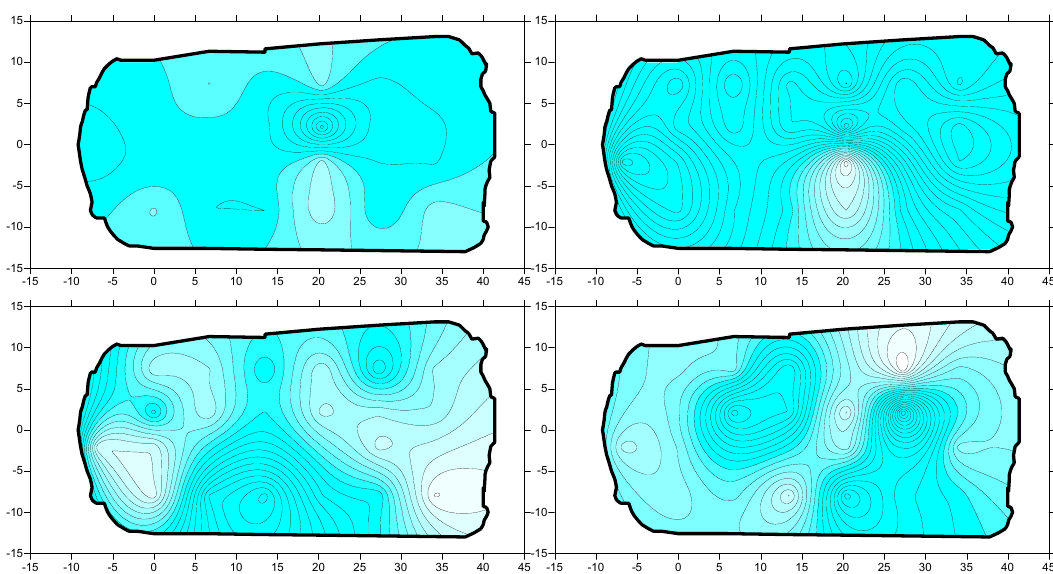
Figure 5. Modal patterns for the carabattola (from top left to bottom right): 107 Hz, 150 Hz, 193 Hz, 247 Hz, 297 Hz, 322 Hz.